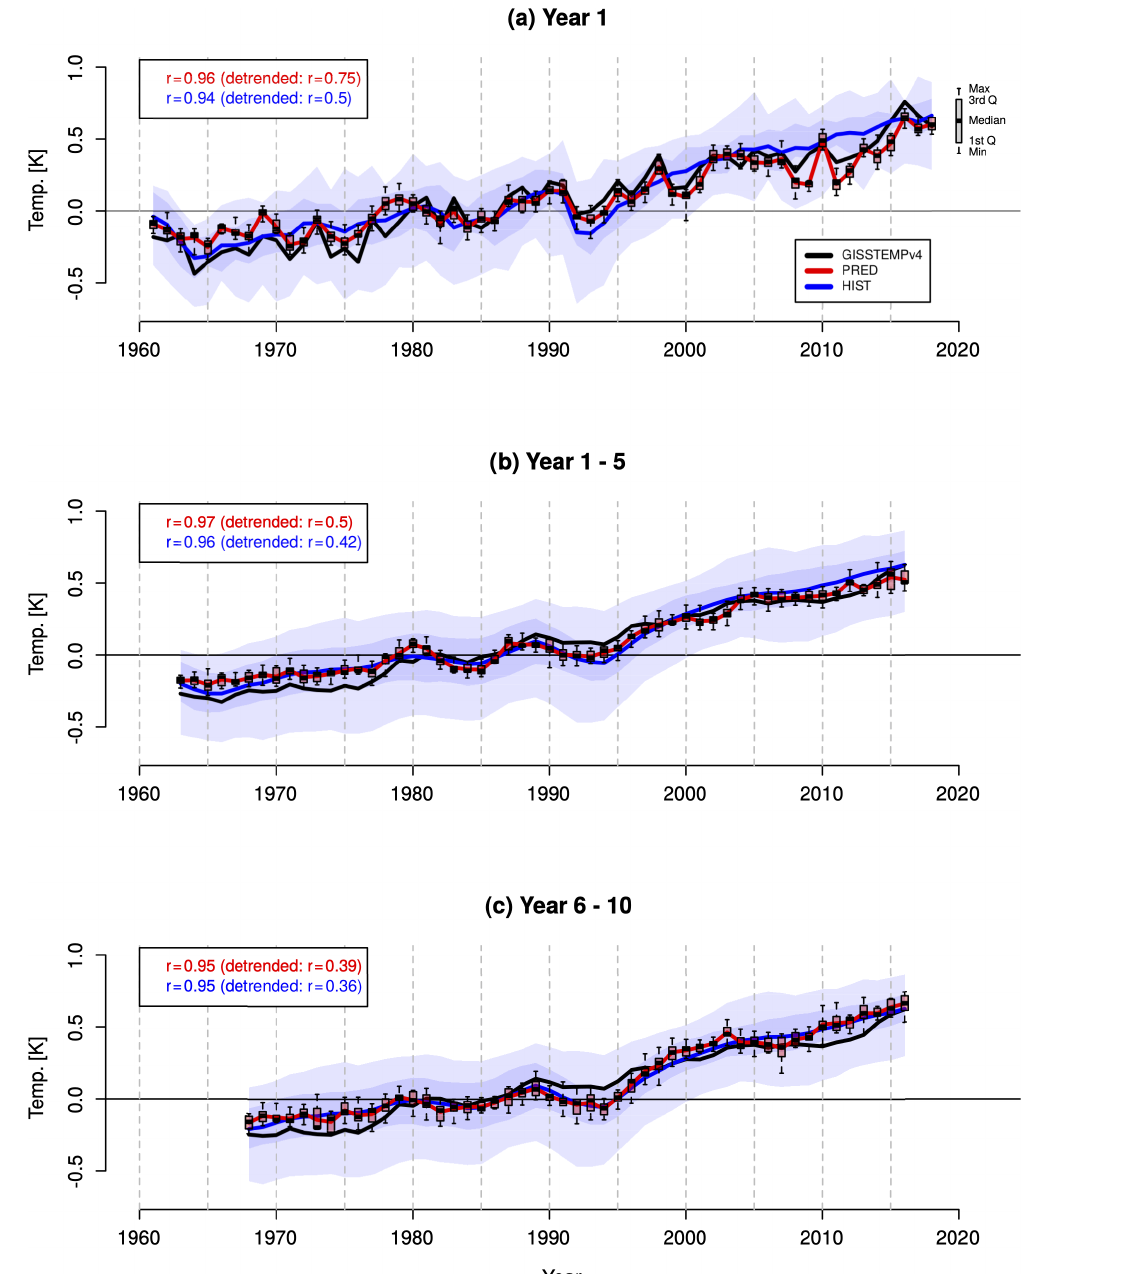
Figure 1. Global mean surface temperature (GMST) annual mean anomaly time series (K) for PRED, HIST (historical+SSP2-4.5) and GISTEMPv4 for (a) forecast years 1, (b) 1–5 and (c) 6–10. The anomalies cover the 1961–2018 period and are referenced to the 1971–2000 mean. Multi-year means (b, c) are plotted on the central year (e.g. 2000 represents the values from 1998 to 2002 in panels b and c). For a fair comparison with observations, PRED and HIST have been masked where and when GISTEMPv4 has missing values. The intra-ensemble spread for PRED and HIST is represented by the box-and-whisker plots and shading respectively. The ACC for PRED and HIST is shown in the top-left corner of each panel, including the ACC after removing a linear trend from the time series (shown in parentheses). All ACC values are statistically significant at the 95%